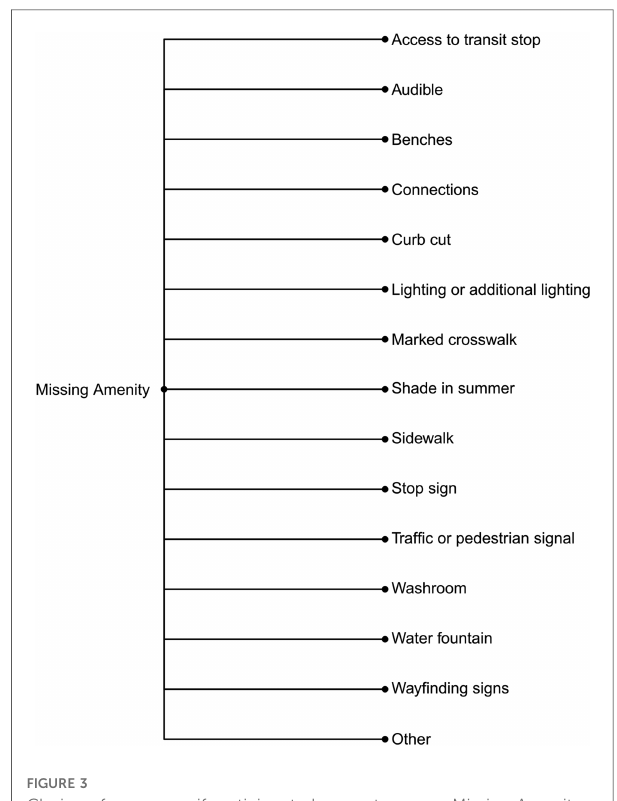
FIGURE 3 Choice of responses if participant chooses to map a Missing